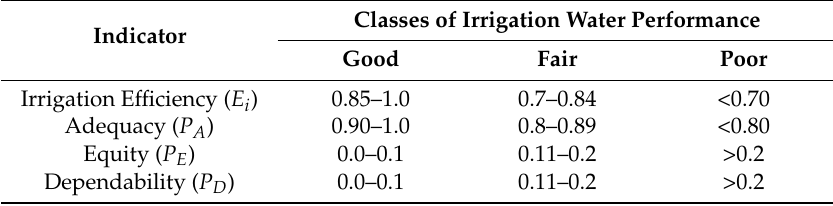
Table 3. Standards of performance indicators for an irrigation scheme